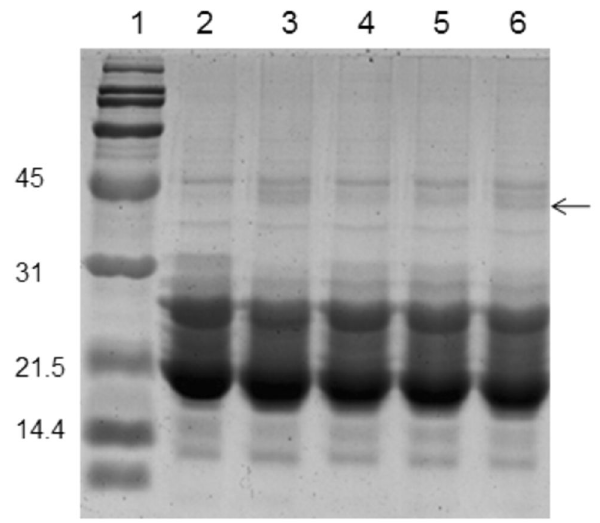
Figure 6. The effect of curcumin and nanocurcumin on protein crosslinking and the aggregation of the soluble fraction of the lens. Soluble protein was loaded onto a polyacrylamide gel. Lane 1 : molecular mass markers; lane 2 : control group; lane 3 : diabetic group (D); lane 4 : D + curcumin group; lane 5 : D + nanocurcumin group and lane 6 : D + blank particles group. Arrow : cross-linked